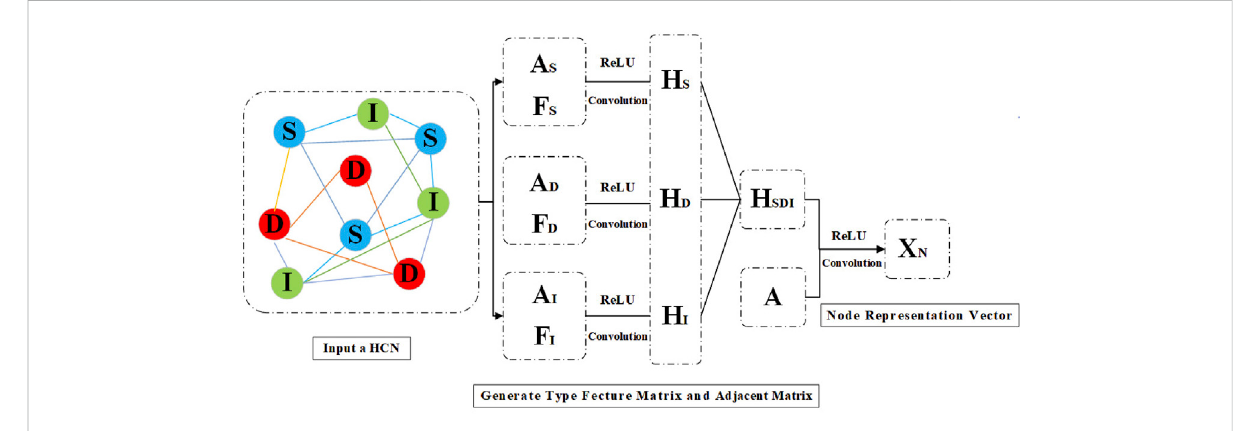
FIGURE 6 Framework of node representation vector